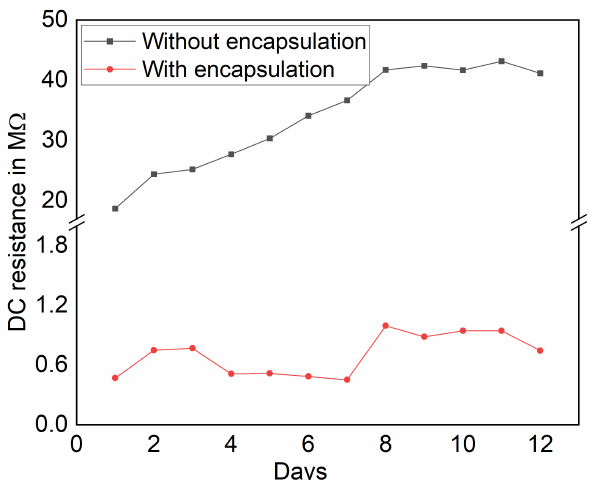
Figure 4. DC resistance of with and without encapsulation of the MWCNT/PDMS pressure sensors over day.